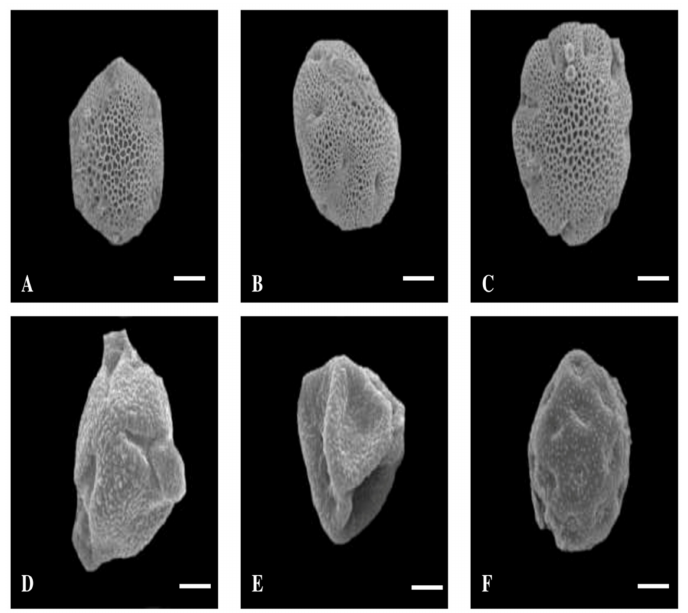
Figure 10. SEM images of pollen grains (Equatorial and Polar axis) and pollen surface ornamentation ( A – C ). The scale bar represents 10 µ m for Cucumis melo subsp. agrestis ( D – F ) and 5 µ m for Euphorbia grandulata